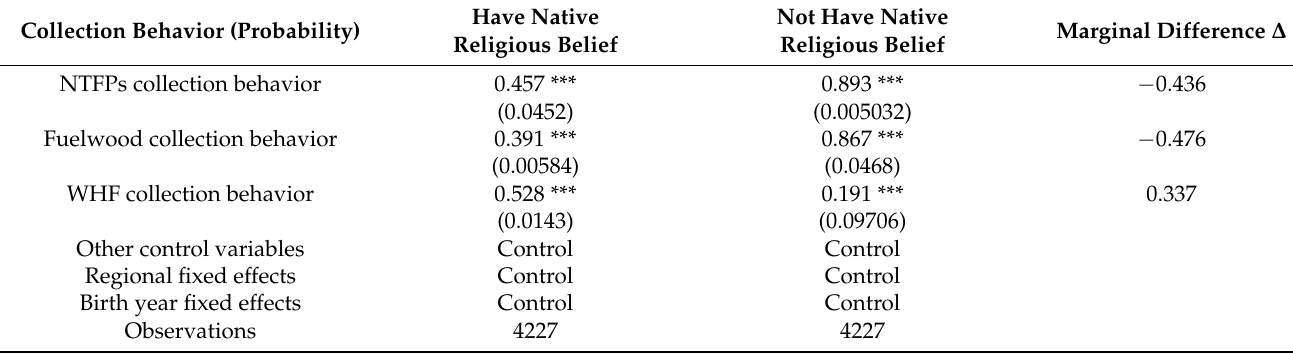
Table 12. The discrete marginal effect of native religious belief on collection behavior.